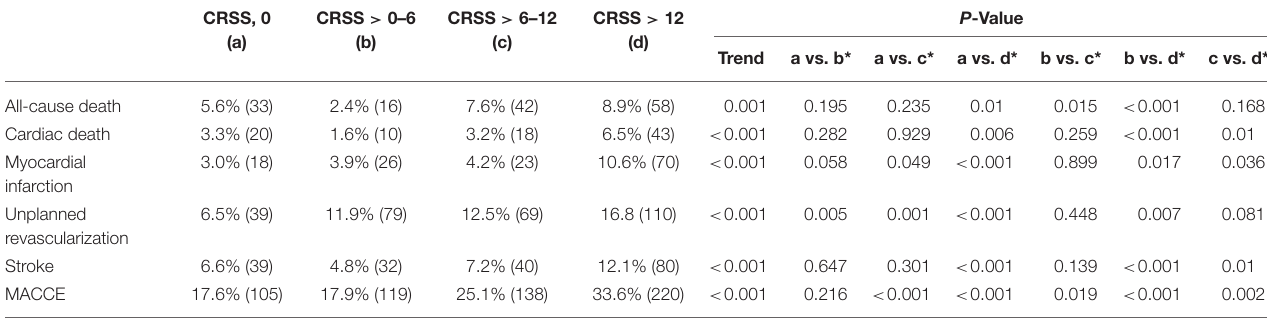
TABLE 3 | Five-Year cumulative incidence of adverse events according to